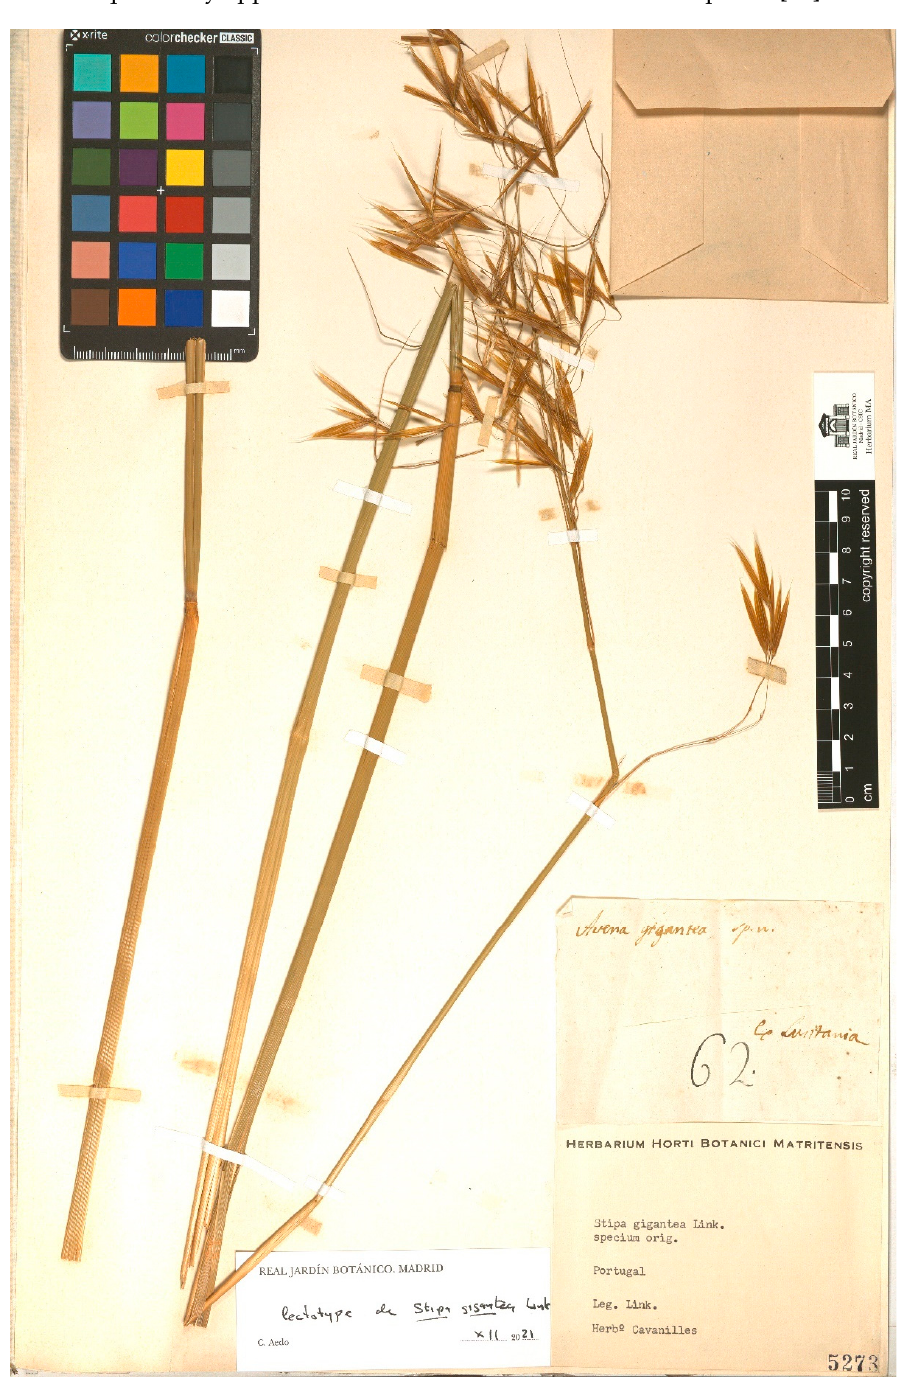
Figure 4. Lectotype of Stipa gigantea Link, in the Herbarium MA (MA00005273). 3.4. Types of the Taxa Described by Hoffmannsegg and Link in the Herbarium MA As indicated above, the lectotypes of the names Airochloa caudata Link, Silene fuscata Link ex Brot., Silene micrantha Link ex Otth and Silene pernoctans Link were proposed by previous authors [53,58]. Vázquez & Barkworth [62] erroneusly proposed a neotype for Stipa gigantea Link. In this work, original material of S. gigantea has been located at MA, and consequently a lectotype has been proposed to replace the